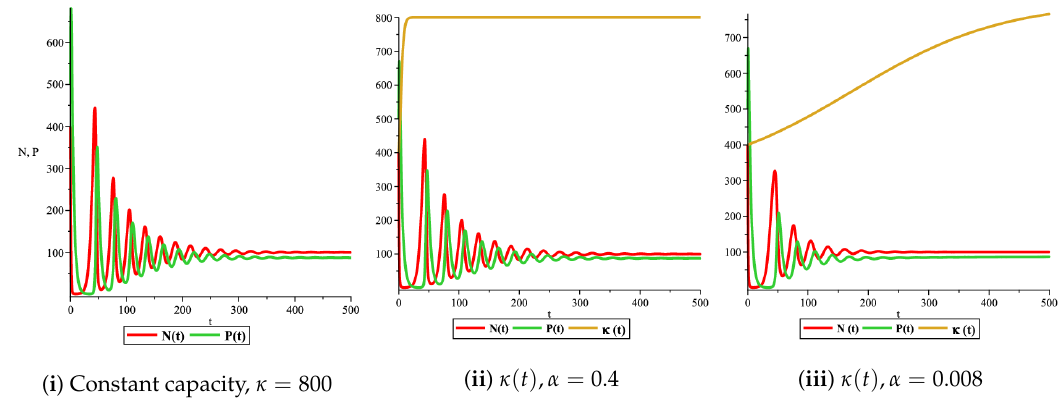
Figure 2. Effect of the logistic variable capacity on the prey–predator model with linear response for κ 1 = 300, κ 2 = 500, r = c = 0.25, a = b = 0.0025.